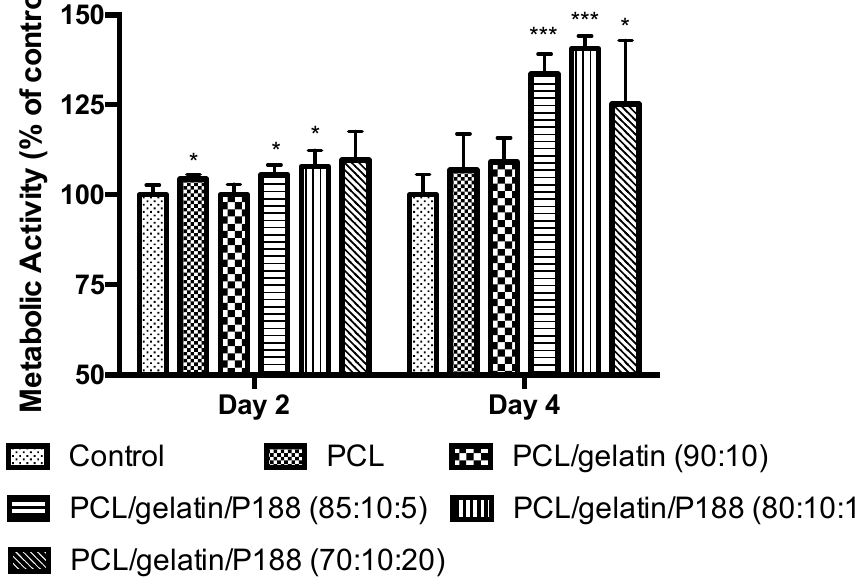
Figure 8. The mean fluorescence indicating the Caco-2 cell viability when cultured on three different PCL/gelatin/P188 (concentration ratios of 85:10:5, 80:10:10, and 70:10:20 %w/v) nanofibrous scaffolds. * p < 0.05; *** p <